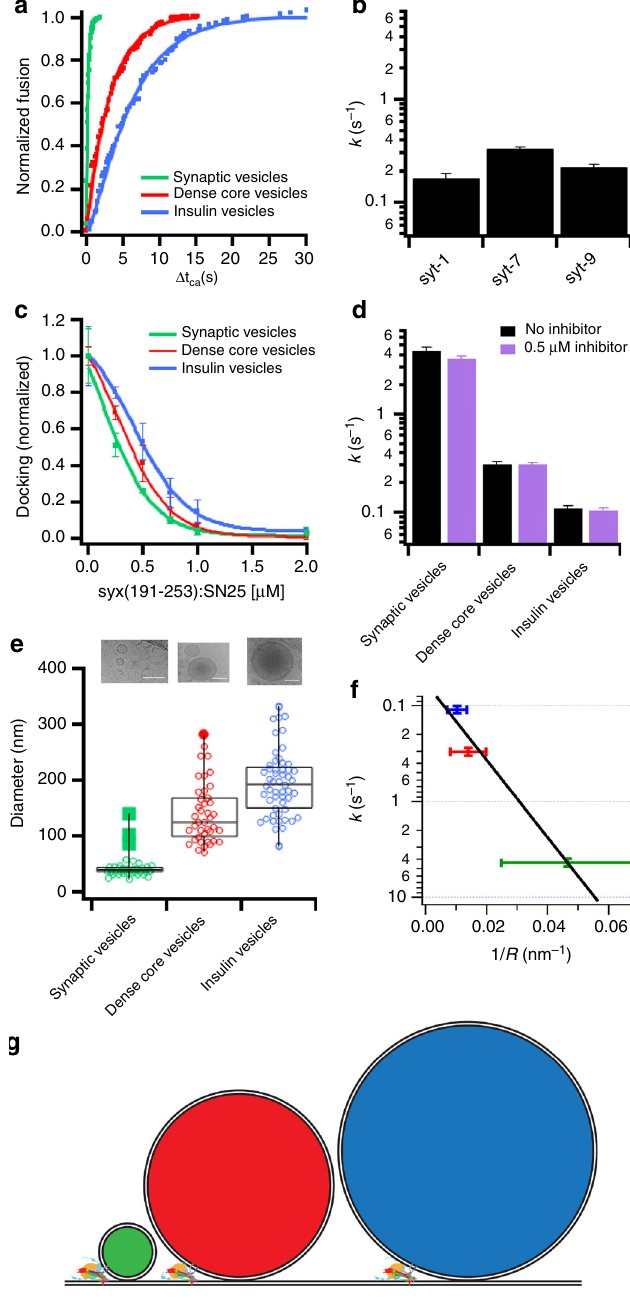
Fig. 5 Secretory vesicle kinetics have a vast range of fusion rates that depend on vesicle size. a Cumulative distribution functions of the delay times of fusion from the time of calcium arrival ( Δ t Ca2 + ) for the three secretory vesicle types. Fusion of vesicles is triggered from a docked state in the presence of syntaxin-1a:dSNAP-25, Munc18, complexin-1, and the C1C2MUN domain of Munc13. Summary statistics for each condition are shown in Supplementary Table 2. b Rate constants of dense-core vesicles puri fi ed from PC12 cell lines depleted of endogenous synaptotagmins and overexpressing single isoforms of synaptotagmin-1, -7, or -9. Vesicles were docked in the presence of syntaxin-1a:dSNAP-25, Munc18, and complexin-1 and triggered to fuse with 100 µ M calcium. Cumulative distribution functions for synaptotagmin knock-ins are shown in Supplementary Fig. 6. membrane Q-SNARE complex (syntaxin-1a(191 – 253):SNAP-25) in the presence of Munc18 and complexin-1 and in the absence of calcium. d The